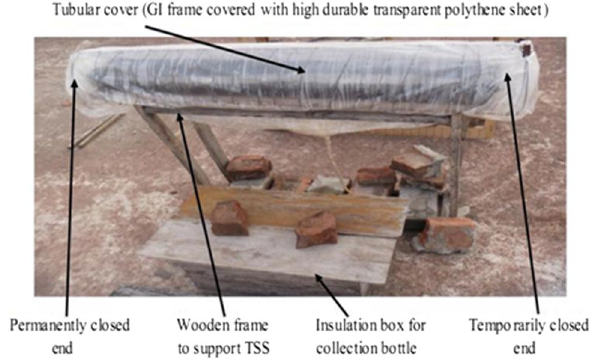
Fig. 2 Photograph of the field experiment